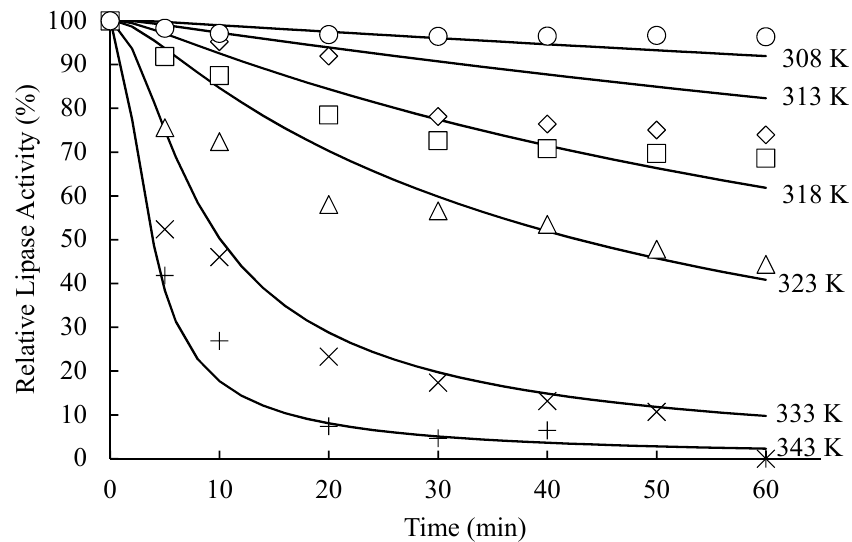
Figure 7. Simulated (line) and measured (points) profiles of relative residual lipase activity in the mesocarp of OPF heat-treated at different temperatures.